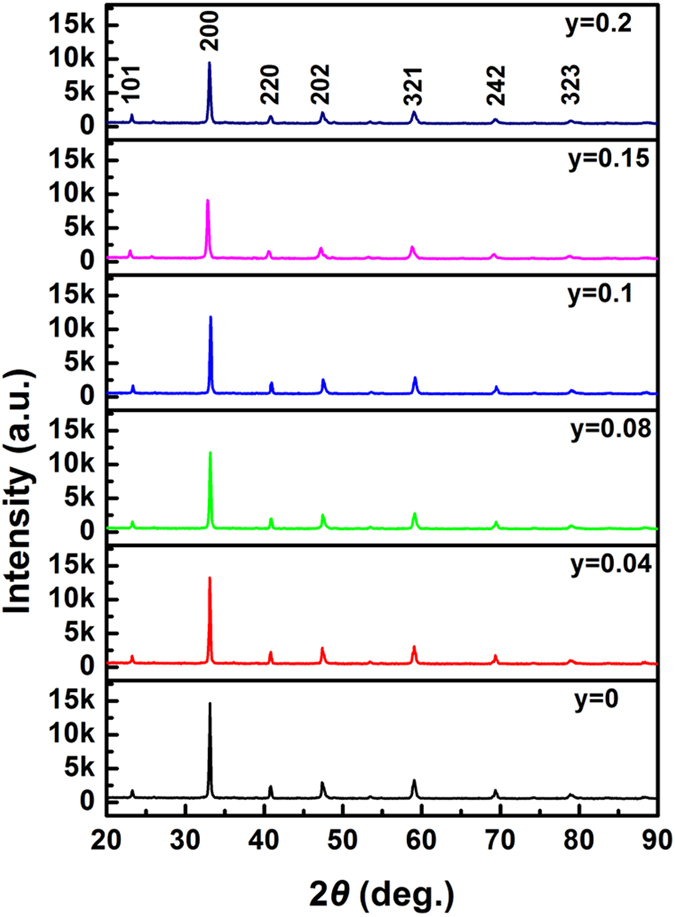
XRD patterns of the Sm0.5Sr0.5Mn1−yCryO3 (y = 0, 0.04, 0.08, 0.1, 0.15, and 0.2) bulk targets.